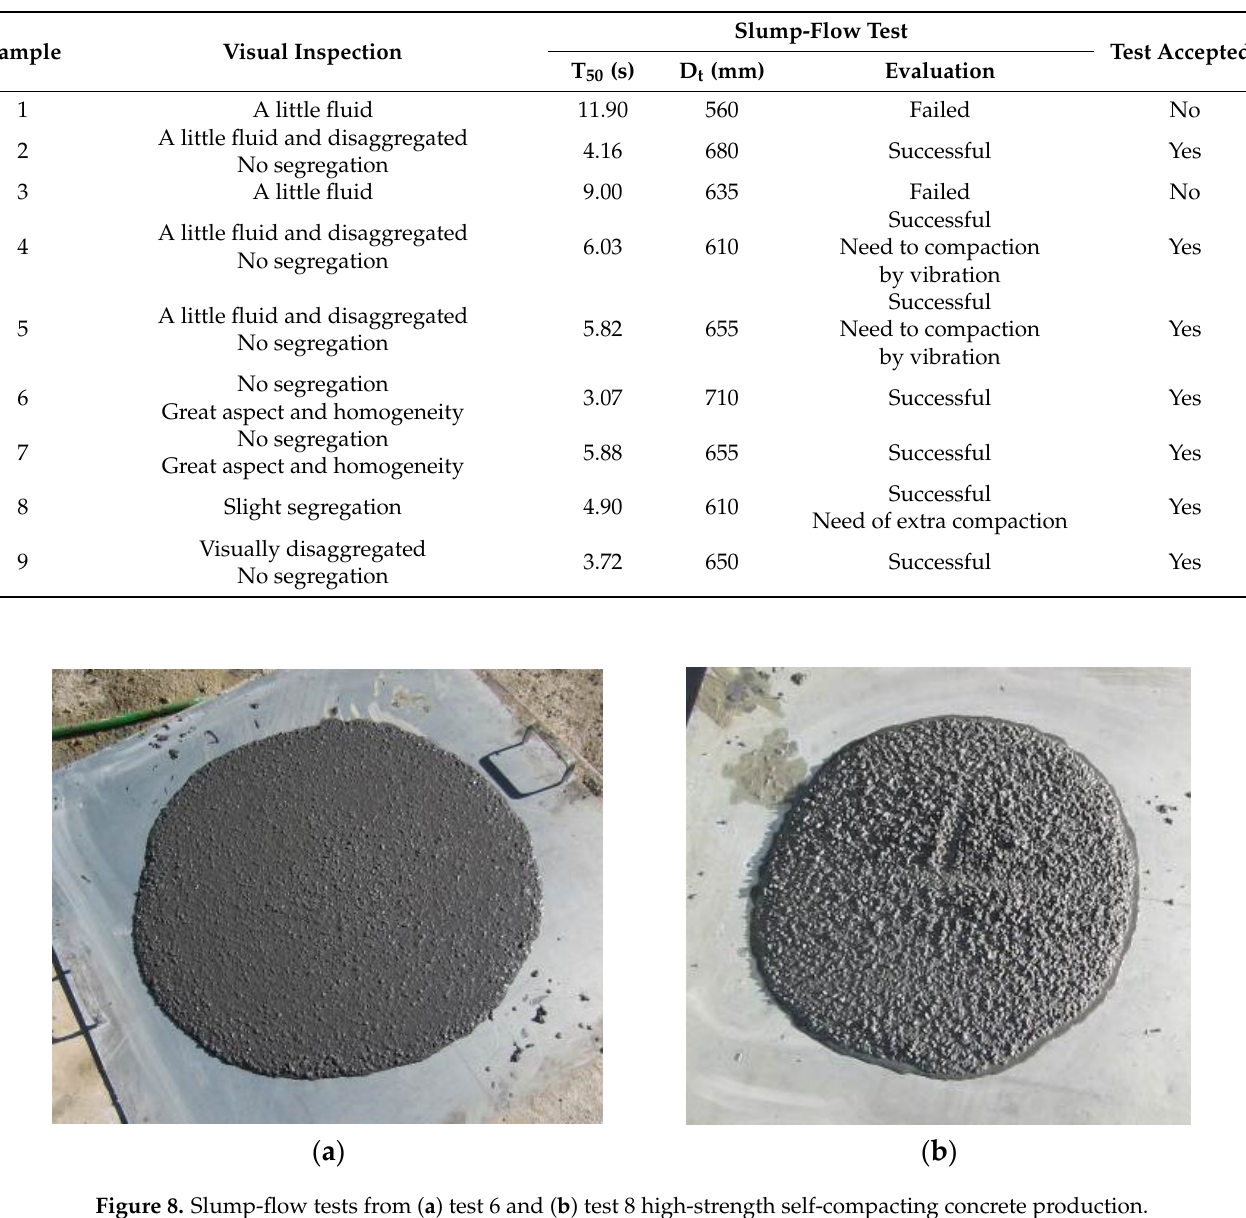
Figure 9. Relative compressive strength of the pilot plant scale high-strength self-compacting con- crete tests. Results show that the scaling up was successful, achieving appropriate mechanical properties when the moisture of the materials to be used is within expected values (too low moisture results in bad workability). Moreover, it was demonstrated that climate con- ditions (temperature and relative humidity) did not affect the concrete production. 4.2.2. Insulating Refractory Concrete Fabrication The insulating refractory concrete was developed with the following ambient condi- tions: min/max temperature 16.2–39.3 °C, average temperature 27.4 °C, min/max relative humidity 16.9–83.5%, average relative humidity 44.1%. Eight different concrete tests were prepared and mixed in two trucks; the results are presented below. The target value of workability is 22 cm for the Abrams cone, set to ensure later trans- fer from the concrete plant to the construction site, at 30 min distance. In this concrete, the gravel particles were immersed in water for one night to get saturation and ensure the